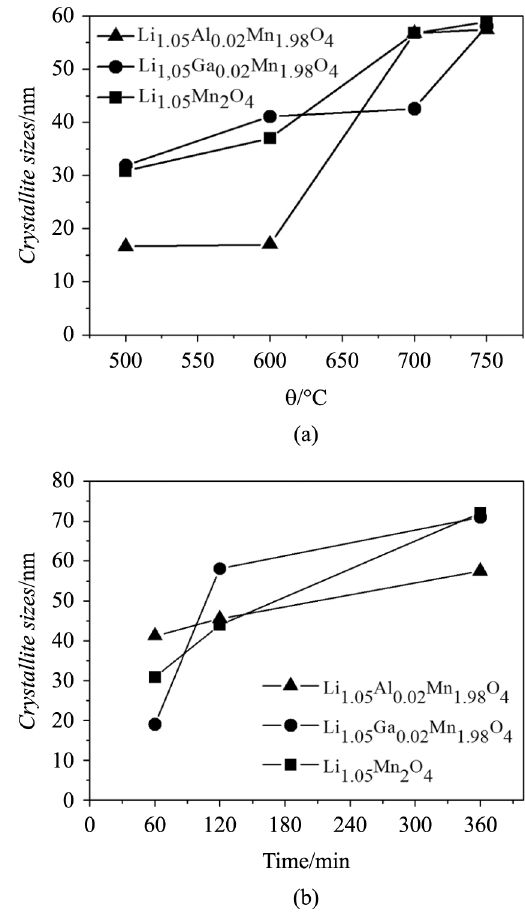
Figure 7. Crystallite sizes of the Li Li Al Mn O as a function of the: (a) temperature calcination 1.05 0.02 1.98 4 (for 120 min); (b) time calcination (at 750